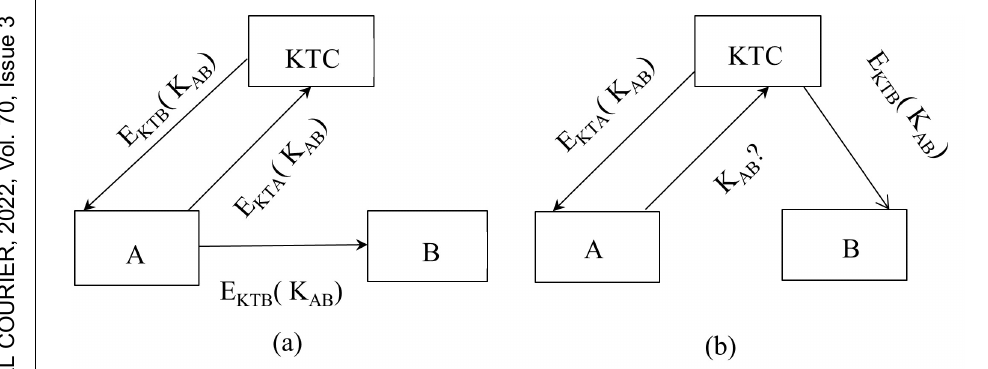
Figure 3 – Models of the Key translation center functioning Рис. 3 − Модели функционирования Центра передачи криптографических